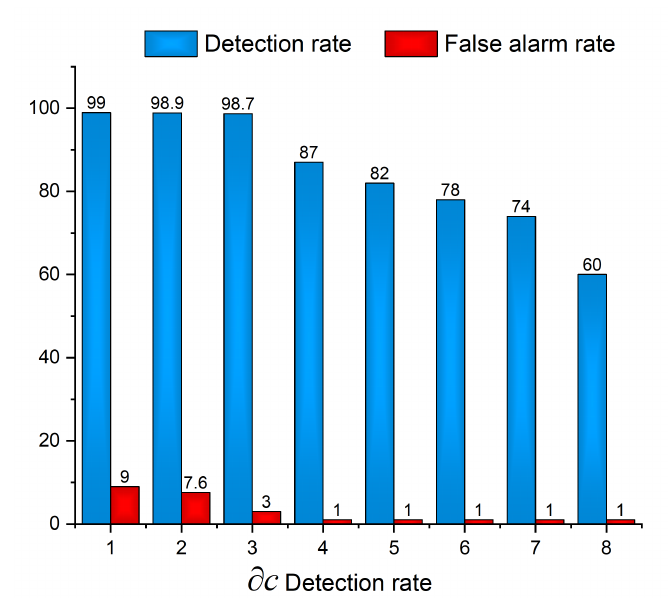
Figure 16. Network traffic identification under different thresholds during the training process.